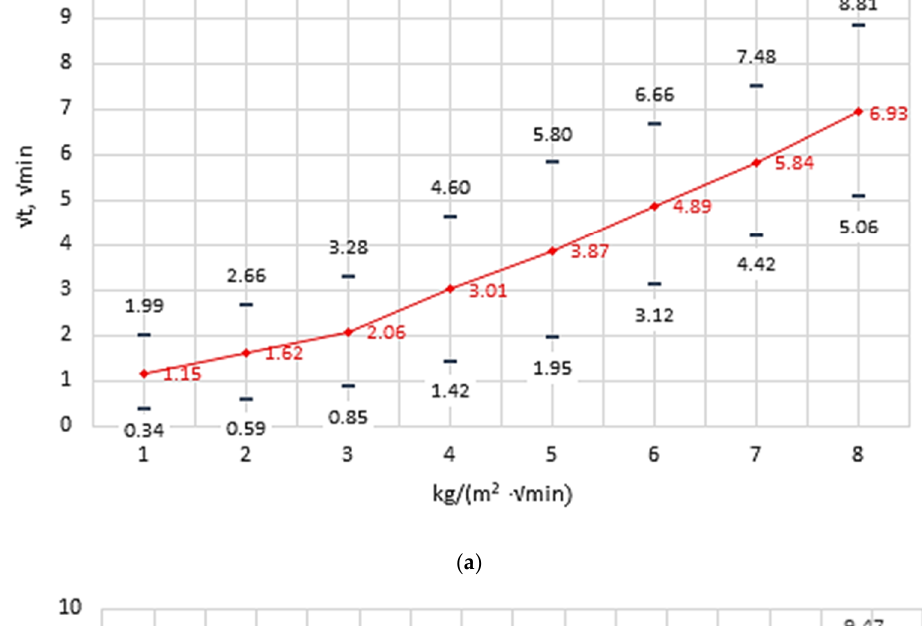
8 of 14 Table 6. Summary of test sample results. Test